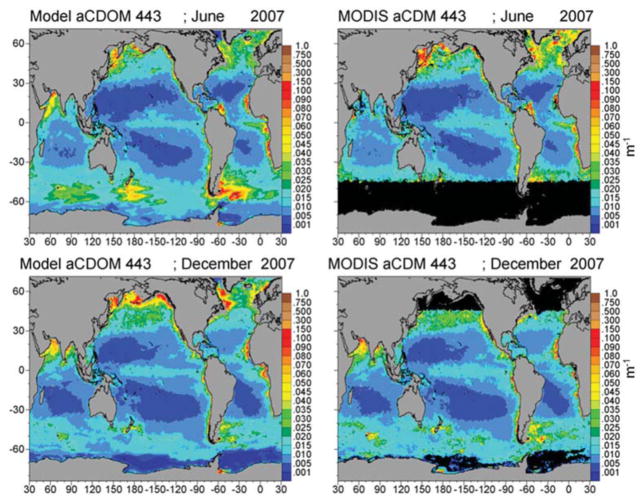
Model assimilated aCDOC 443 nm for June and December 2007 compared to MODIS-Aqua aCDM 443 nm.